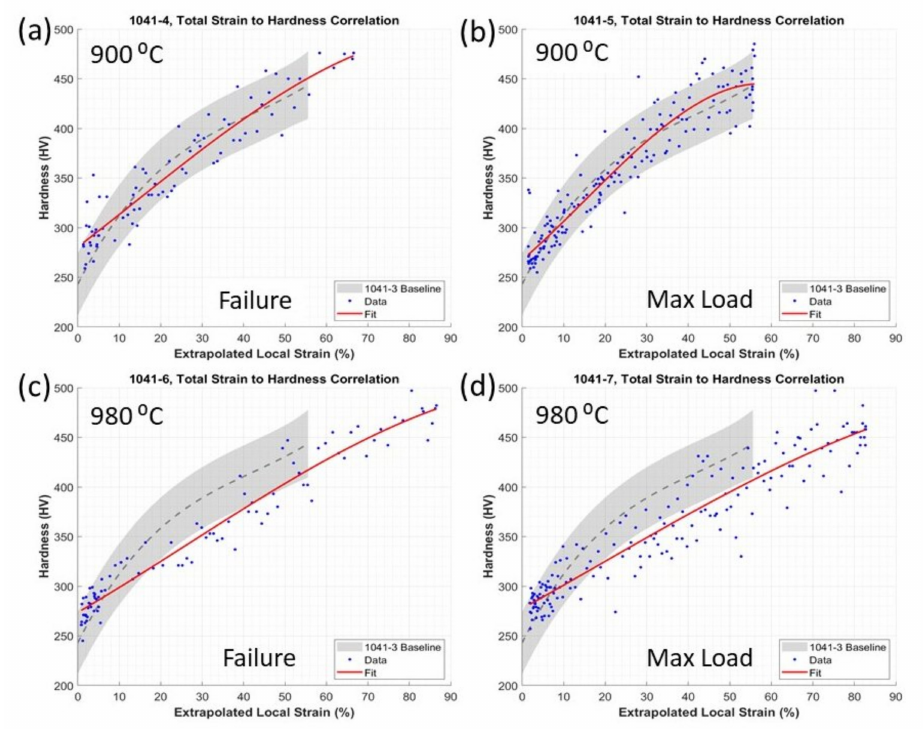
Figure 13. Total strain and micro hardness correlation for prestrain summed with post-heat-treatment strain. Figures ( a , b ) show the effect of 900 ◦ C heat treatment on micro hardness and ( c , d ) show the effect of 980 ◦ C heat treatment on micro